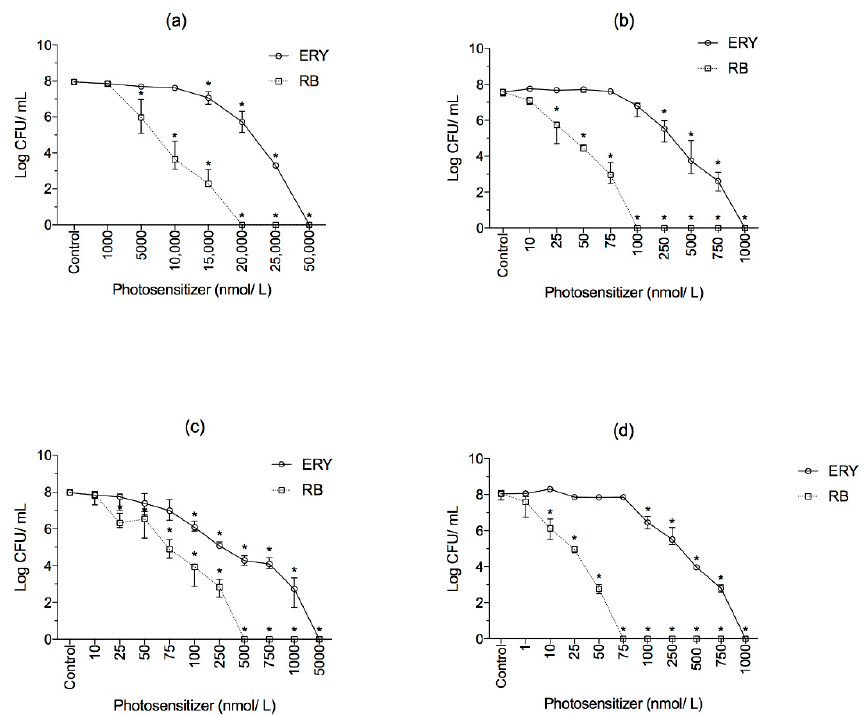
Figure 4. Survival of ( a ) E. coli , ( b ) S. aureus , ( c ) E. hirae and ( d ) L. innocua planktonic cells subjected to aPDI using different concentrations of ERY and RB. Cells were incubated for 10 min in the dark and then illuminated with green LED light source for 10 min. The control group represents the cells incubated only with PBS. Values are shown as medians, including 25% and 75% quantiles of at least three independent experiments. * p < 0.05 compared to the control.